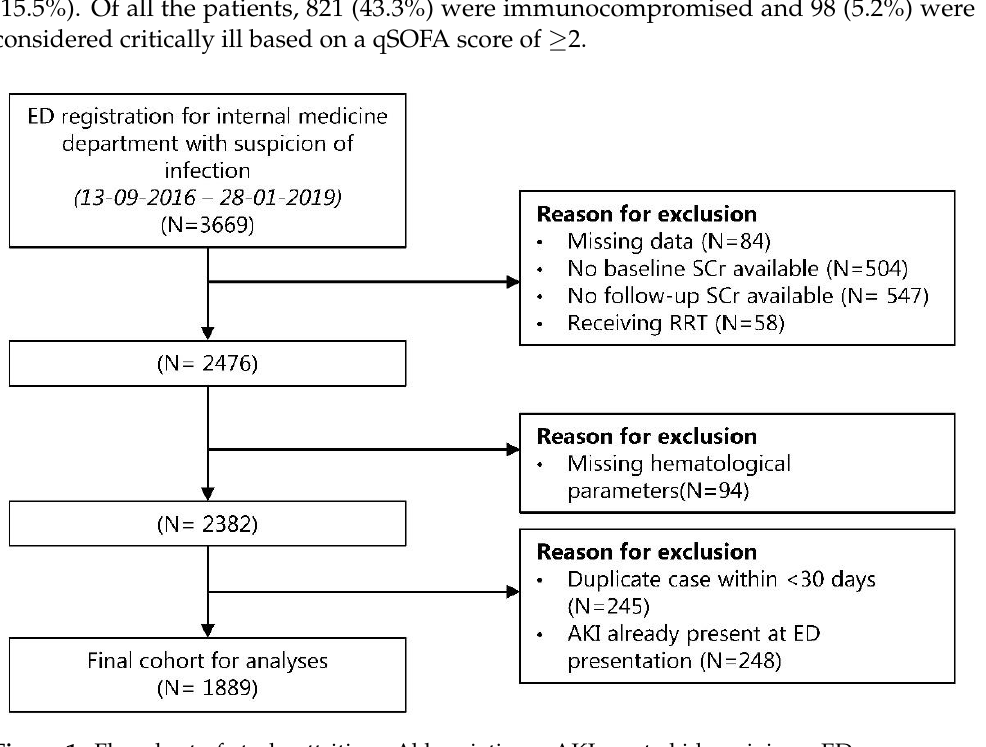
Figure 1. Flowchart of study attrition. Abbreviations: AKI, acute kidney injury; ED, emergency department; RRT, renal replacement therapy; SCr, serum creatinine. Table 1. Baseline characteristics of study population at emergency department by AKI status.